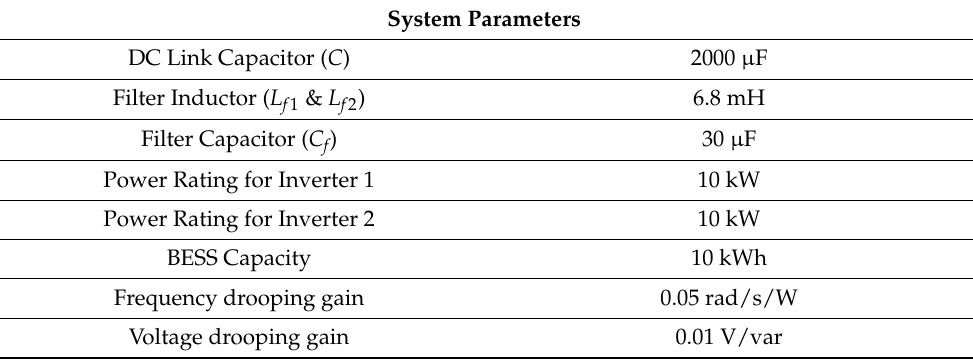
Table 1. C MG system Parameters. Table 1. CMG system Parameters.